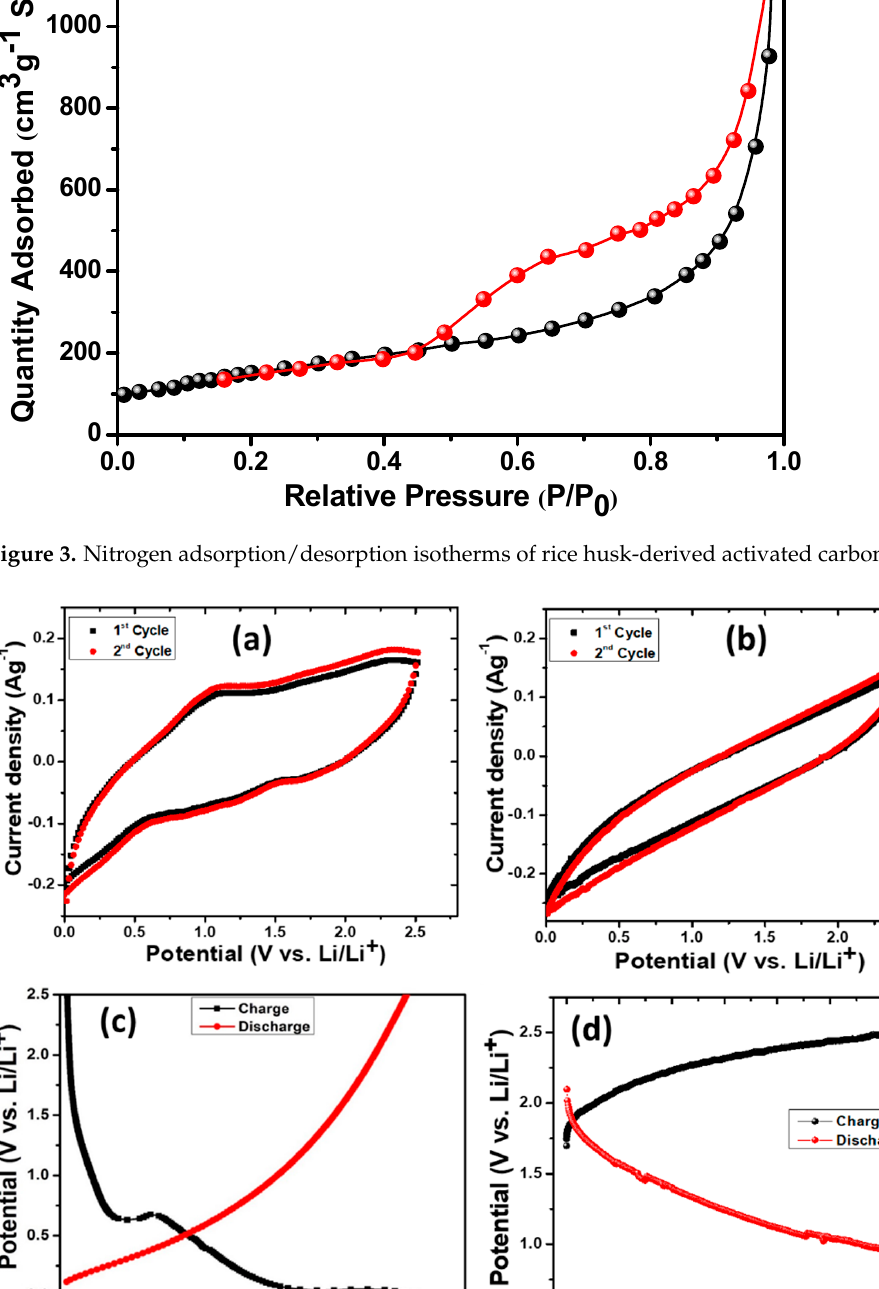
Figure 3. Nitrogen adsorption/desorption isotherms of rice husk-derived activated carbon.